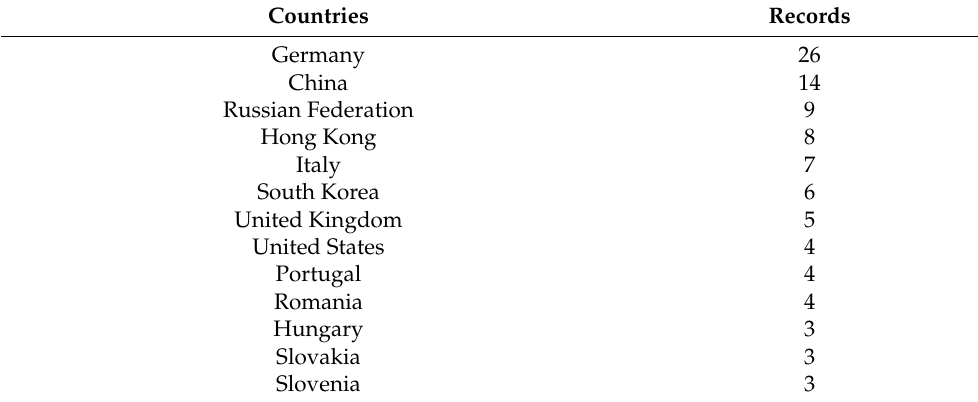
Table 3. Records by